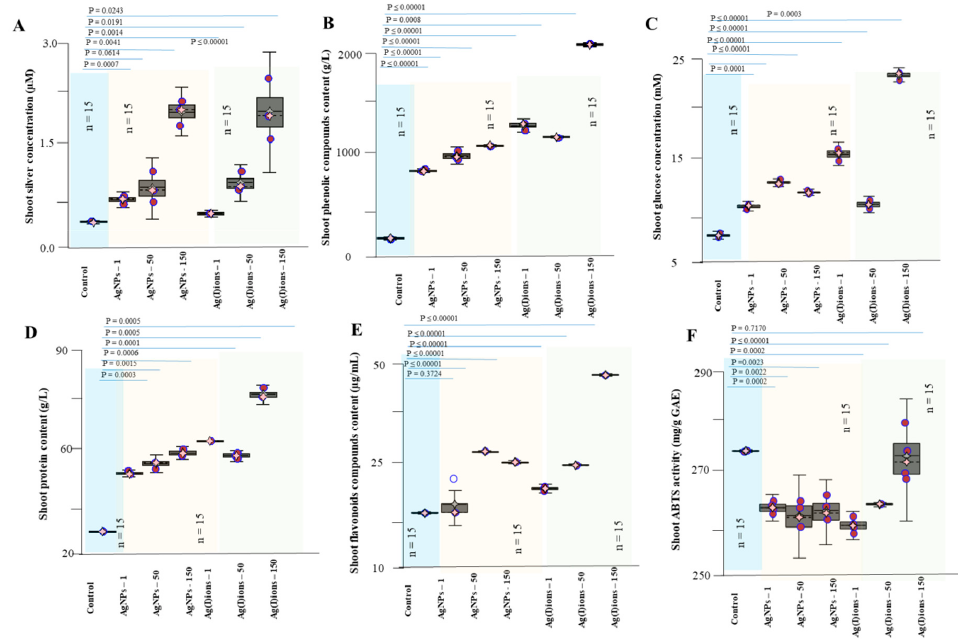
Figure 9. Influence of AgNPs and Ag(I) ions on the above-ground parts of germinated plants. The amount of ( A ) silver ions, ( B ) phenolic compounds, ( C ) glucose, ( D ) total proteins, and ( E ) total flavonoids. ( F ) ABTS activity. Plants were collected after 96 h of exposure to hydroponics. Plants were collected in triplicate every day and then processed according to the procedure described in the Material and Methods section. Data are presented as the average of all experimental data.